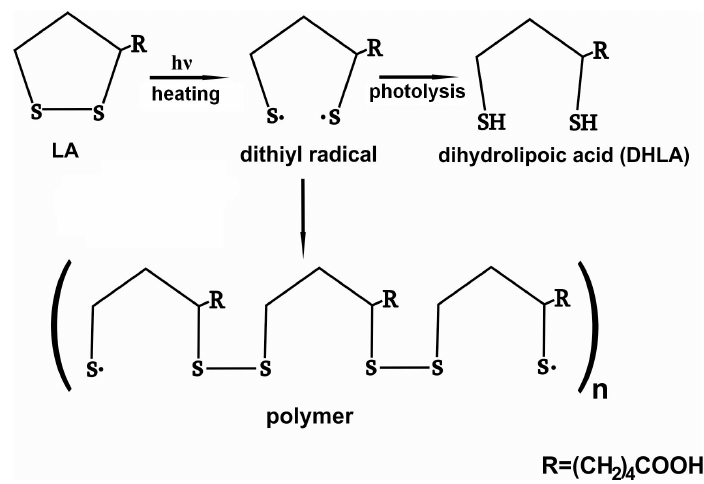
Figure 8. Schematic presentation of products of photo or thermal degradation of LA.